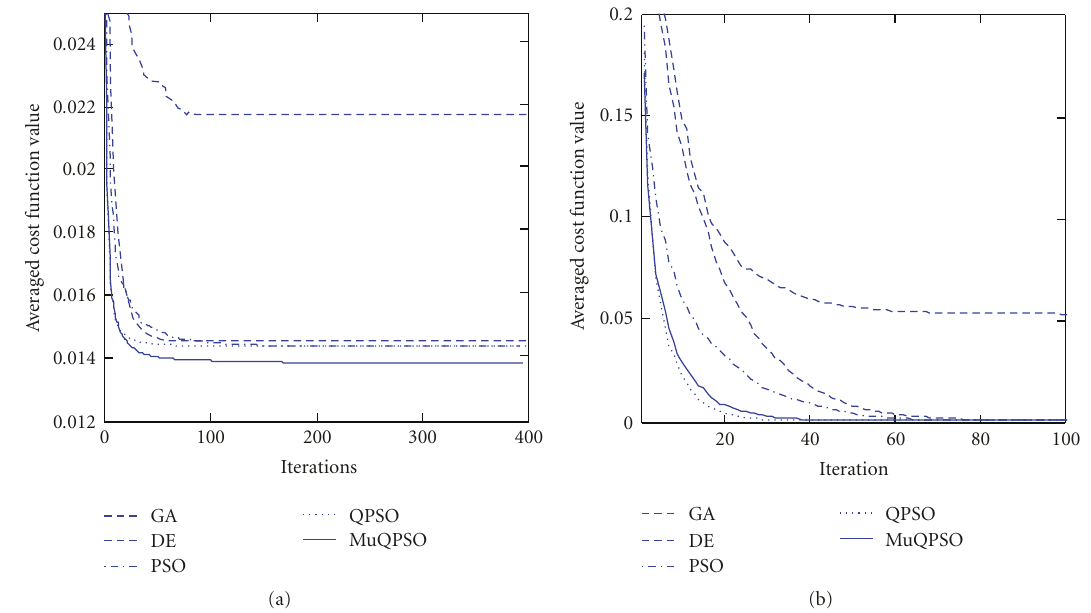
Figure 2: Comparison of convergence behaviours for (a) Example 2 and (b) Example